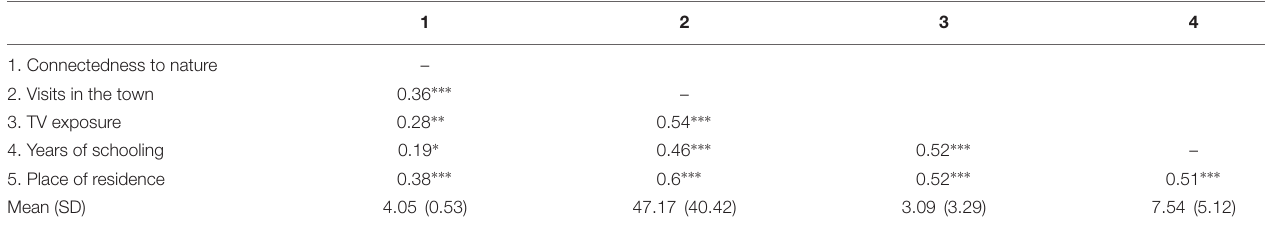
TABLE 2 | Correlations between connectedness to nature score and indicators of modernization, and mean scores for each